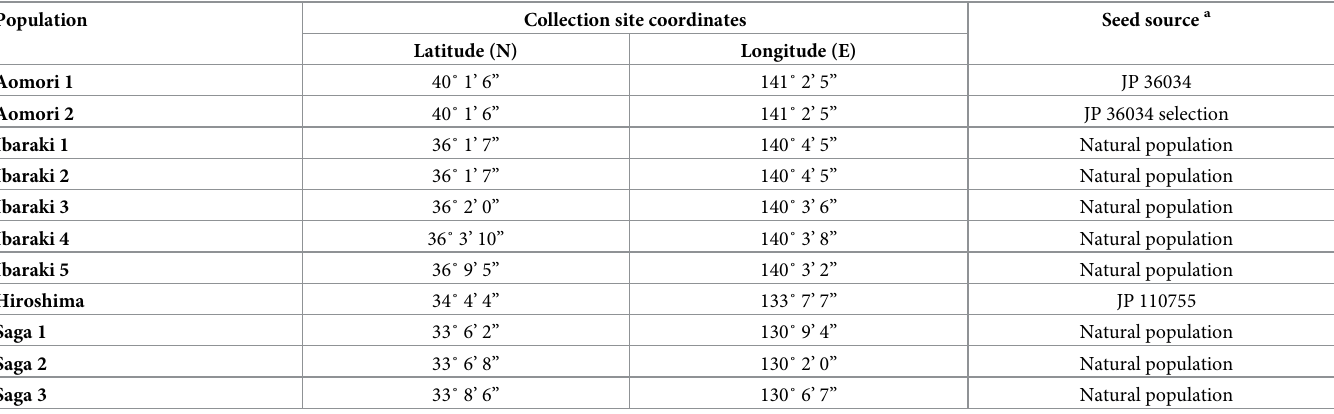
Table 1. Details regarding wild soybean populations.